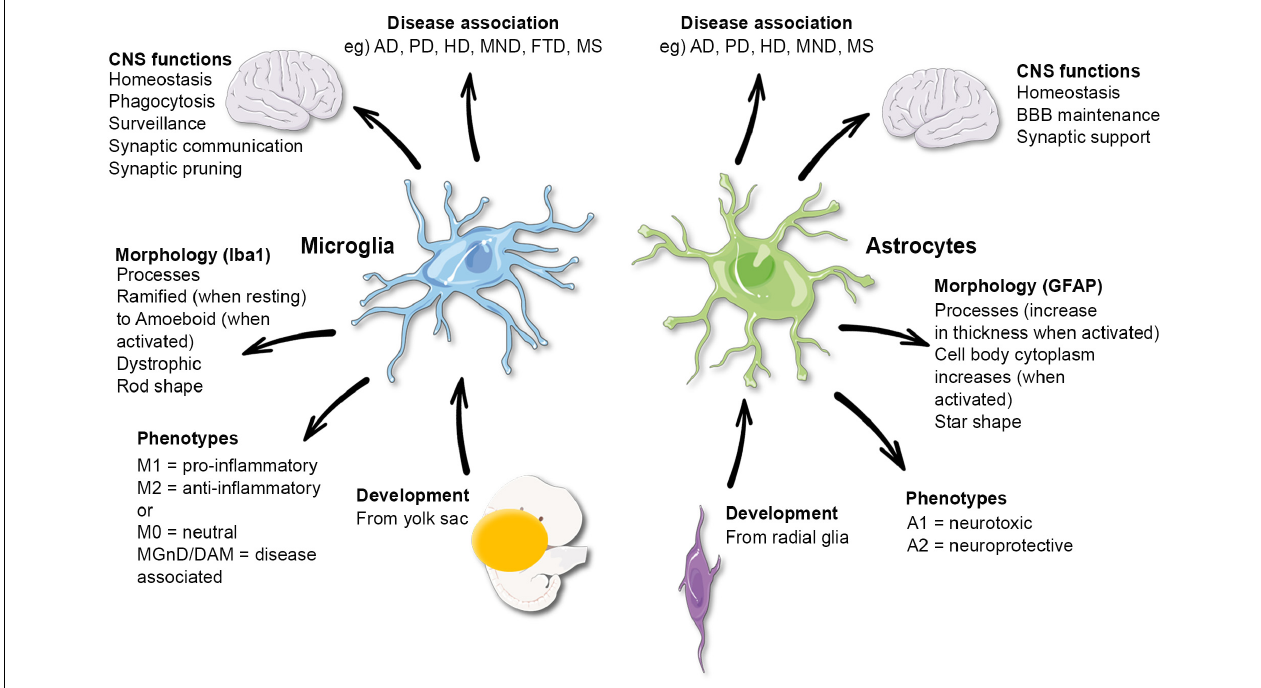
FIGURE 1 | Functional and morphological characteristics of microglia and astrocytes. AD, Alzheimer’s disease; PD, Parkinson’s disease; HD, Huntington’s disease; MND, motor neuron disease; FTD, frontotemporal dementia; MS, multiple sclerosis. Microglia phenotypes have been disputed and may not reflect their functions.